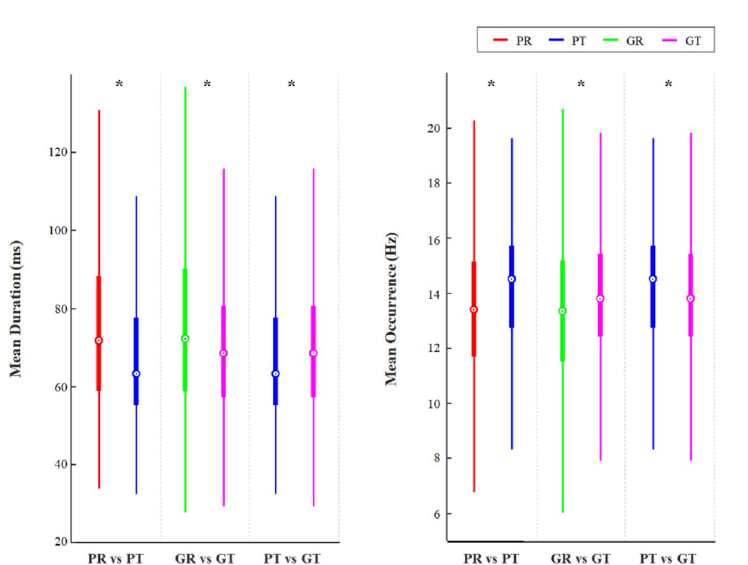
Figure 3. Changes in mean duration and mean occurrence depending on task state and performance. Boxplot represents first quantile, third quantile, and the median. Group differences were tested with Mann–Whitney test. After Bonferroni–Holm correction for multiple comparisons, a significant difference is marked by an asterisk. PR poor performers in the resting state, PT poor performers in task state, GR good performers in resting state, GT good performers in task